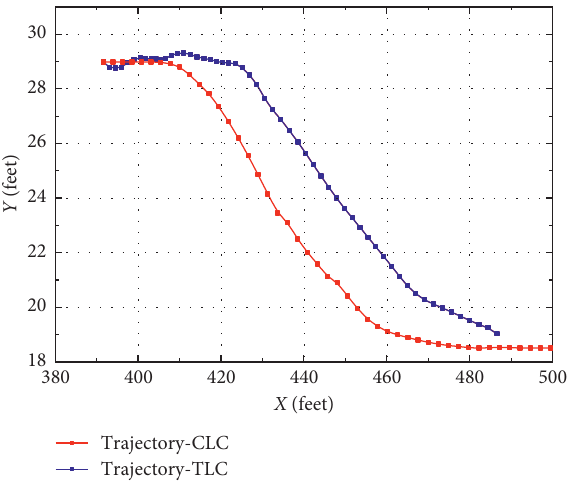
Figure 13: Vehicle trajectory of TLC and CLC. Table 4: Indicator comparison of TLC and CLC.